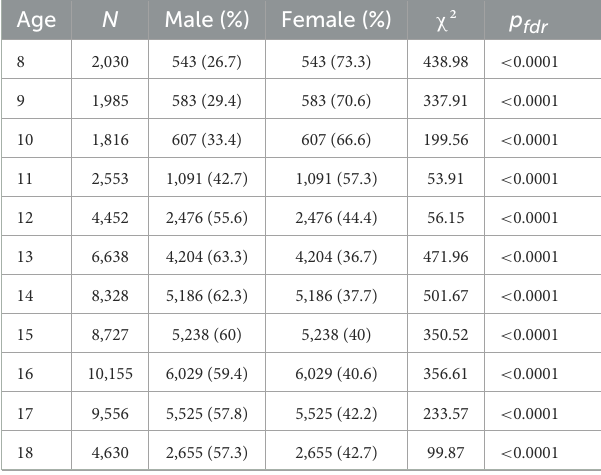
TABLE 1 Age and sex distributions of the